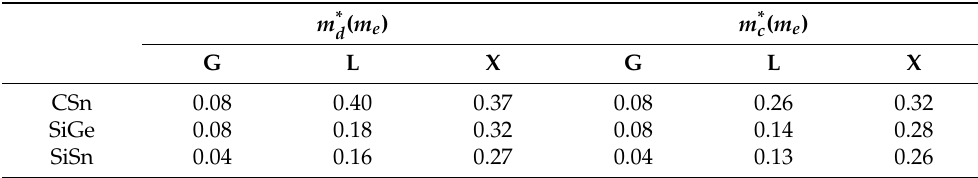
Table 2. The effective mass of CSn, SiGe, and